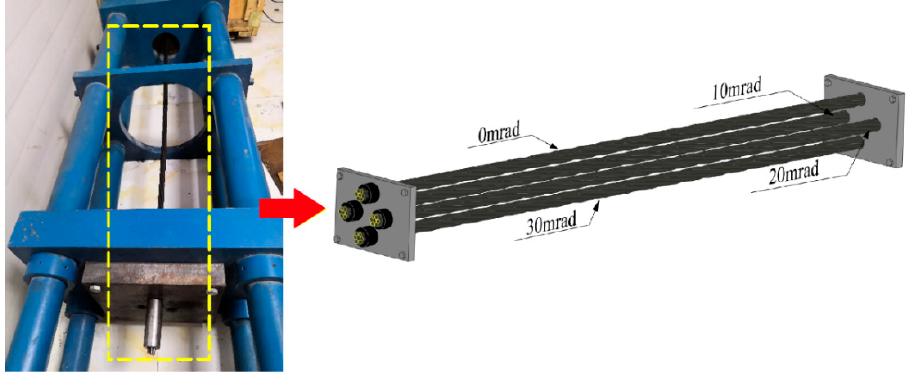
Figure 17. ( a ) Modified anchor plate; and, ( b ) failure cross-section of the seven-wire strand.